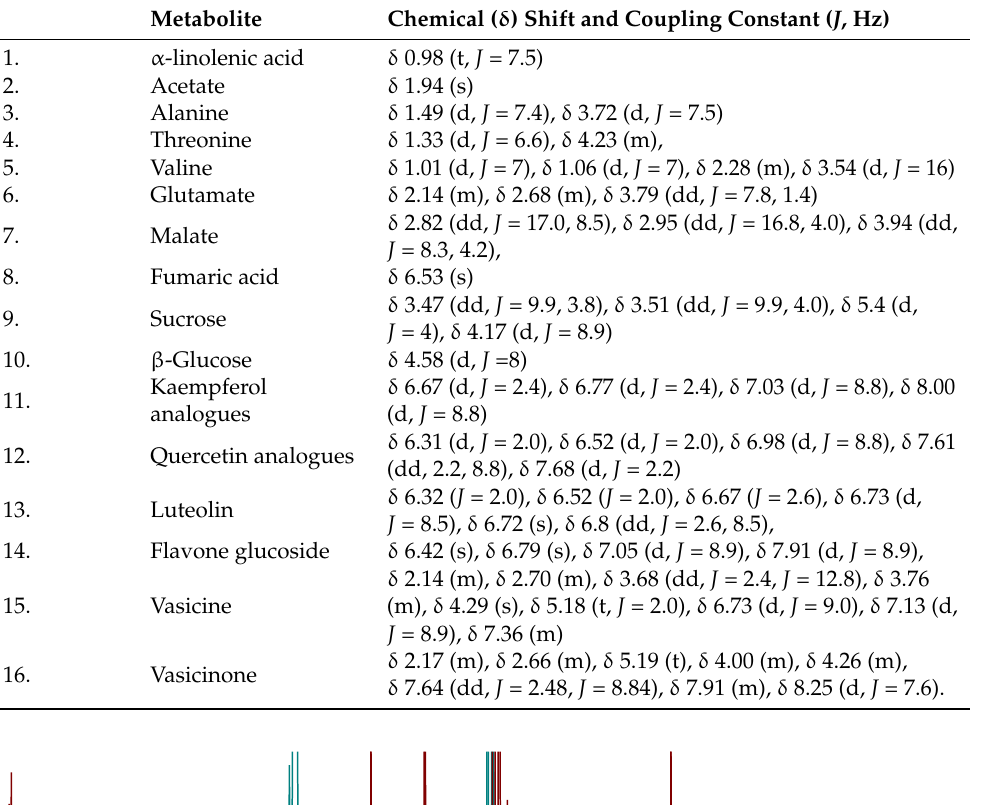
Table 2. 1 H chemical shifts ( δ ) and coupling constants (Hz) of metabolite of Vasaka leaves obtained